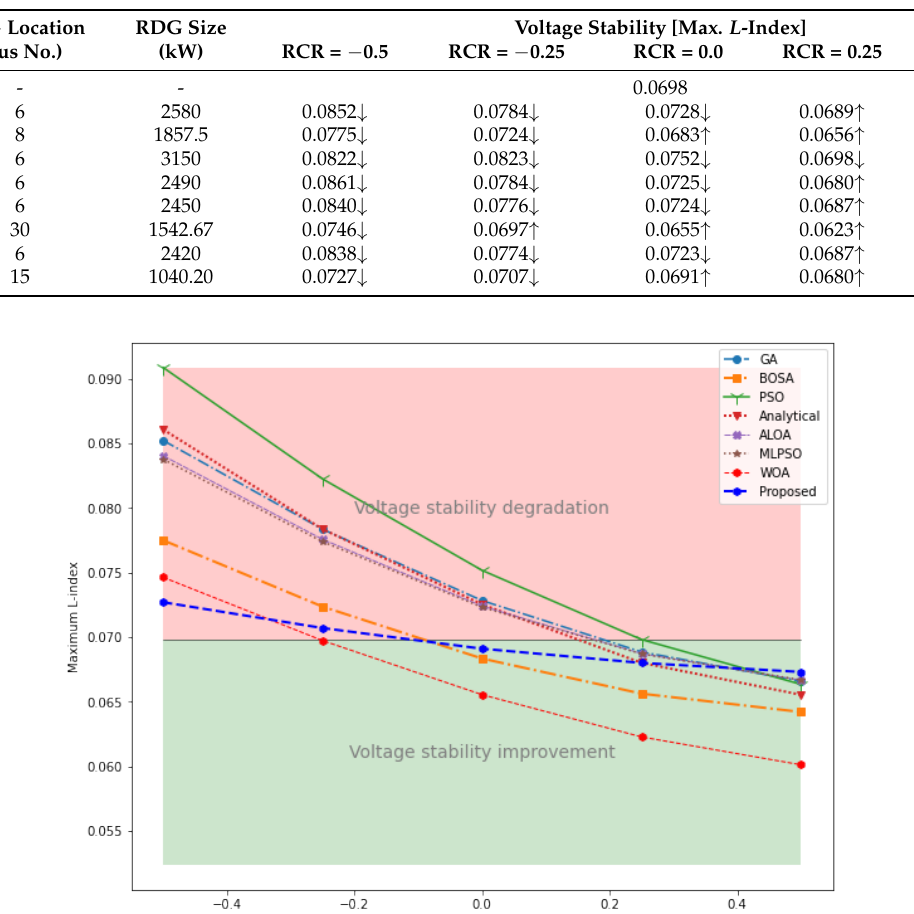
Table 10. Result for installing one RDG of IEEE 33-bus distribution test system with the different reactive compensation ( ↑ : improvement of voltage stability; ↓ : degradation of voltage stability)